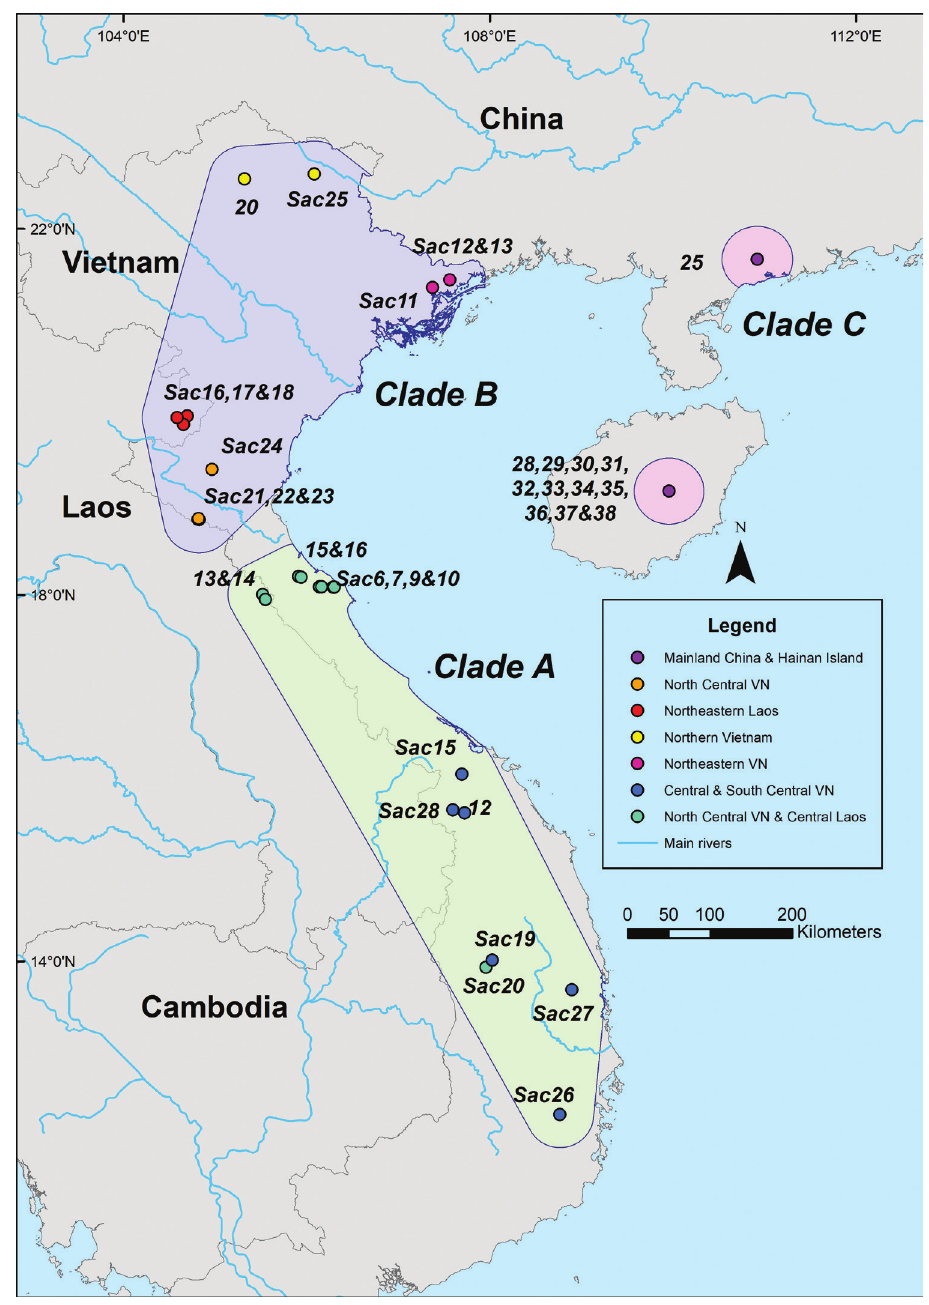
Figure 2. Samples of Sacalia quadriocellata collected from the field and local trade. Three delineated areas, A, B and C, represent distributions of three phylogeographic clades shown in Figs 3, 4. See Table 1 for more information of the